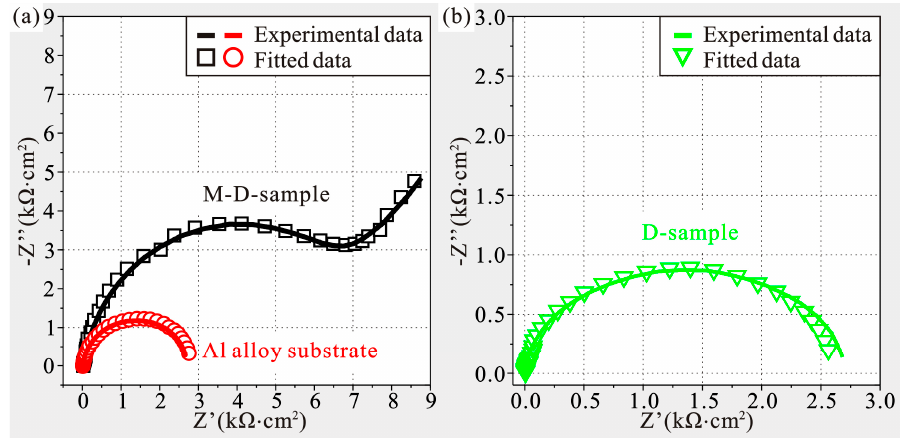
Figure 8. Experimental and fitted Nyquist plots of ( a ) Al alloy substrate, modified deposited sample (M-D-sample) and ( b ) deposited sample (D-sample).